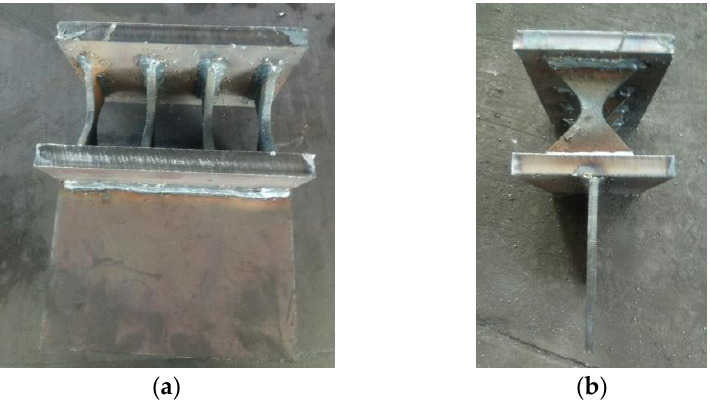
Figure 9. Manufactured LYP steel energy absorbers. ( a ) Front view; ( b ) side view.